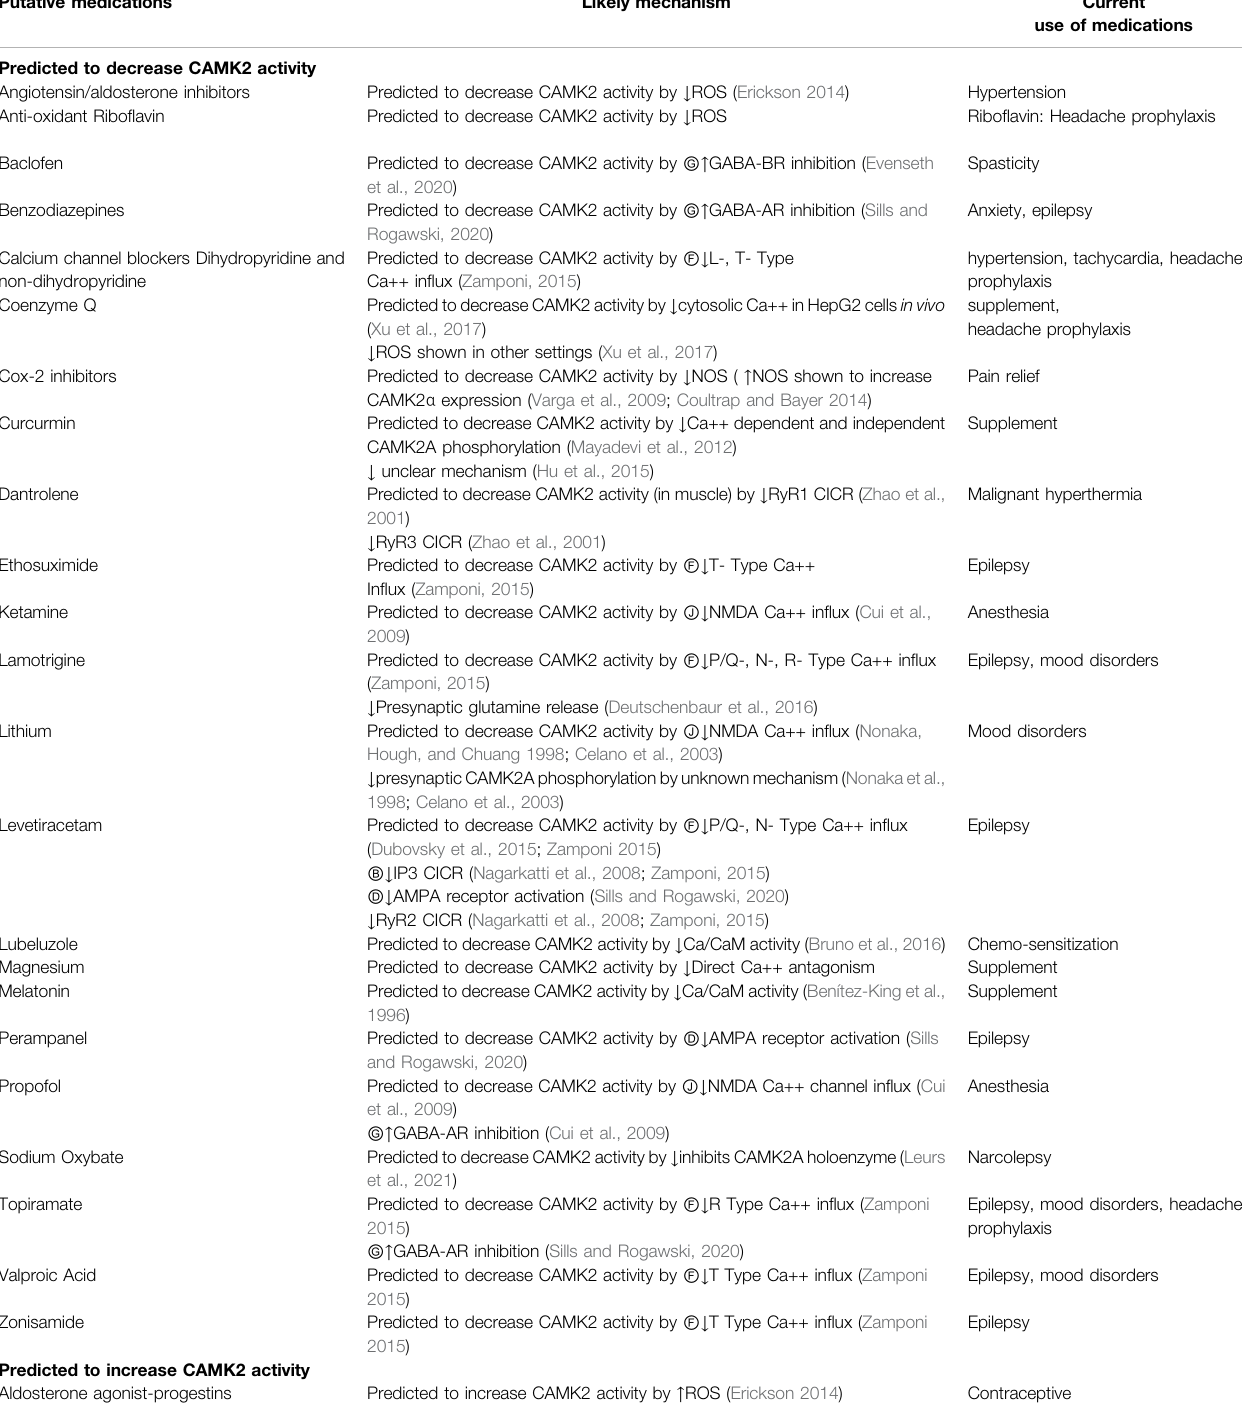
TABLE 1 | Putative medications are not limited to those listed